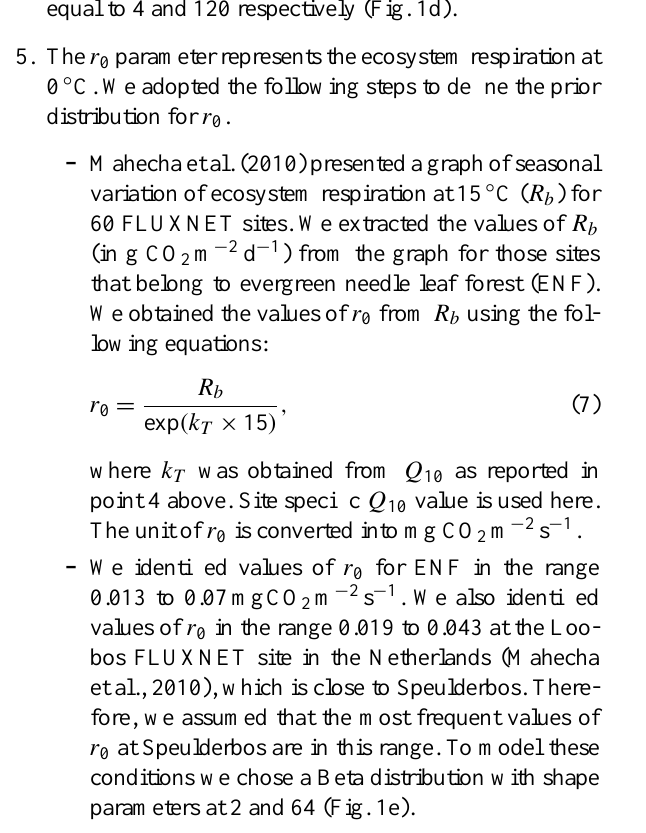
Information about